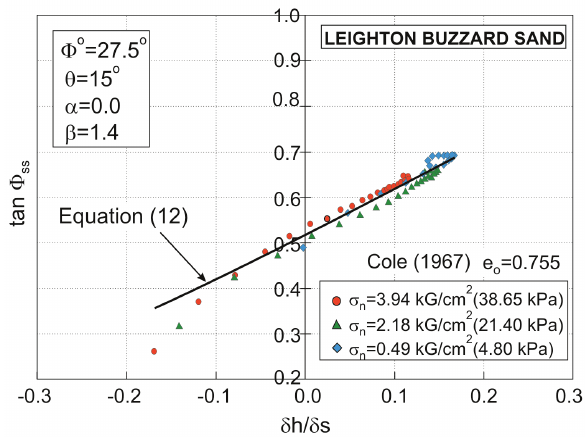
Fig. 4. Influence of the stress level on the stress ratio-dilatancy relationship in simple shear conditions